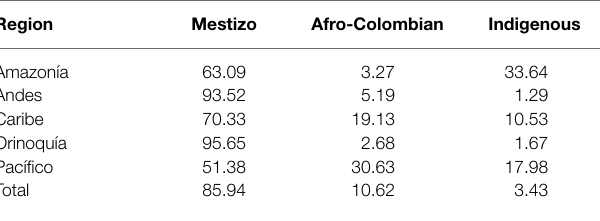
TABLE 1 | Ethnic group population percentages for the five broad geographic regions and the entire country. Region Mestizo